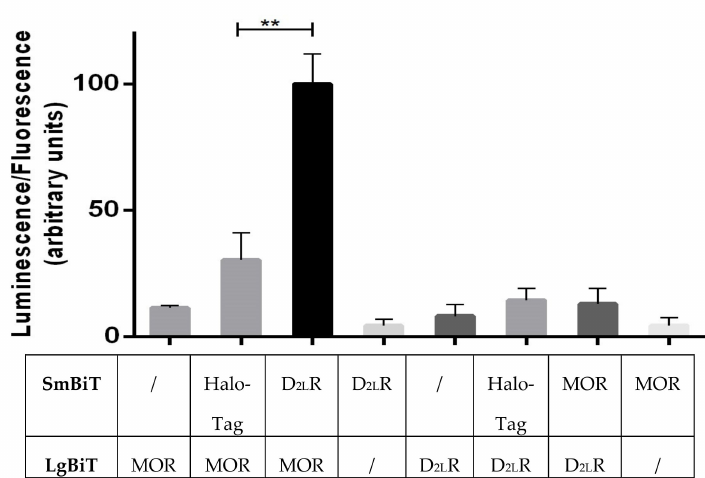
Figure 4. Analysis of D 2L R interaction with MOR using NanoBiT ® . HEK 293T cells were transfected with SmBiT and LgBiT-tagged receptor constructs as indicated above. The luminescent signal in cells cotransfected with D 2L R fused to SmBiT and MOR fused to LgBiT was significantly higher (~3.5 fold) than the signal of the negative control, cells coexpressing Halotag-SmBiT and MOR-LgBiT. Three independent experiments were performed, and the results were expressed as mean ± SD (** p <